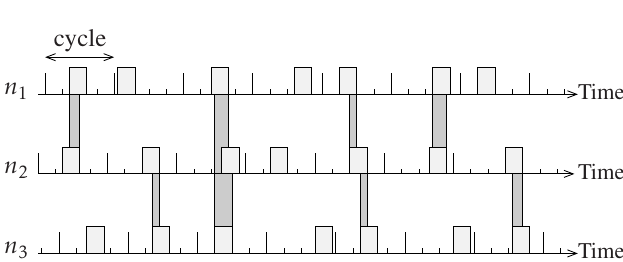
Figure 1. Example of the activities of three neighbor nodes with the protocol of [27], with a duty-cycle of 25% (this long duty-cycle is chosen for clarity).